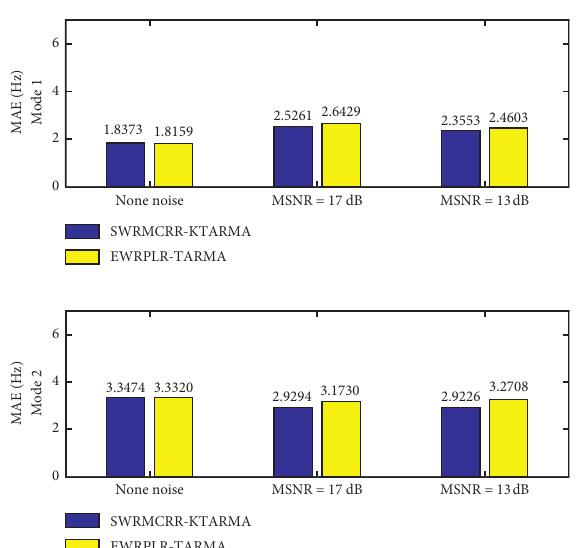
Figure 7: The MAE values of modal frequency estimates based on the experimental response signal with various added numerical noises for all 10 Monte Carlo runs.